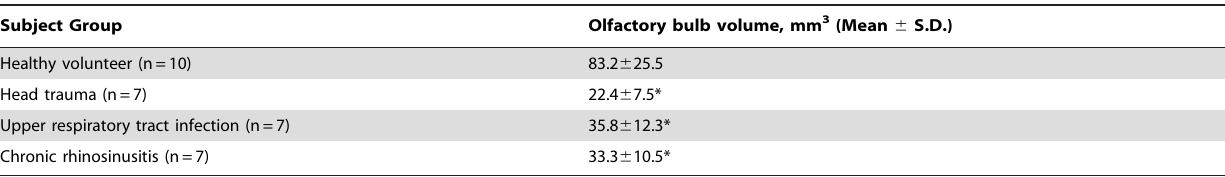
Table 3. Olfactory bulb volume measurements in